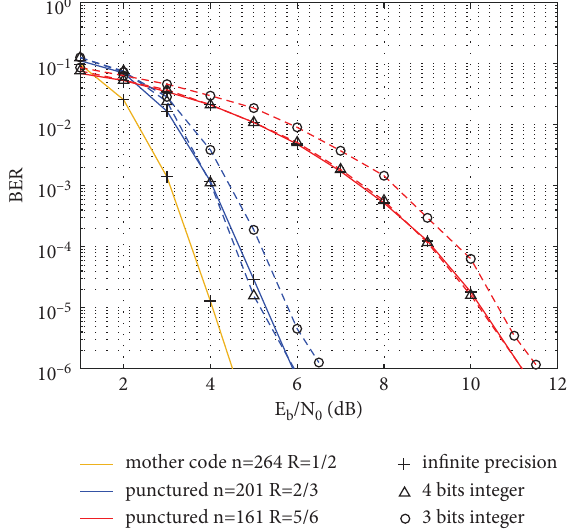
Figure 16: BER performance of puncturing LDPC codes. Te solid lines represent infnite precision and the dashed lines mean integer